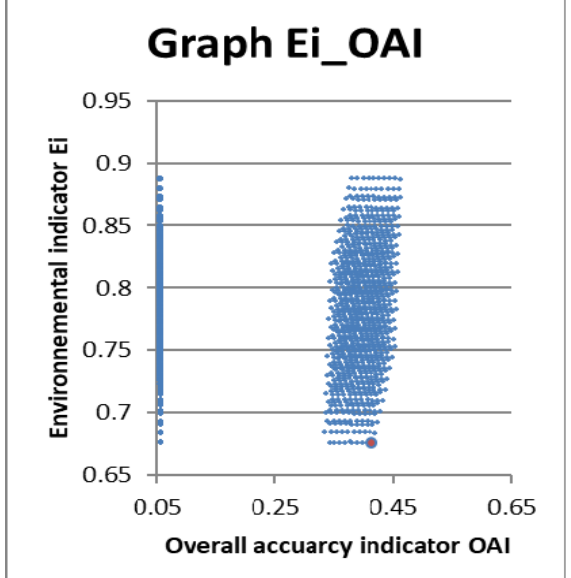
Figure 5. (OAI) and (E i ) for each candidate solution for the solution A